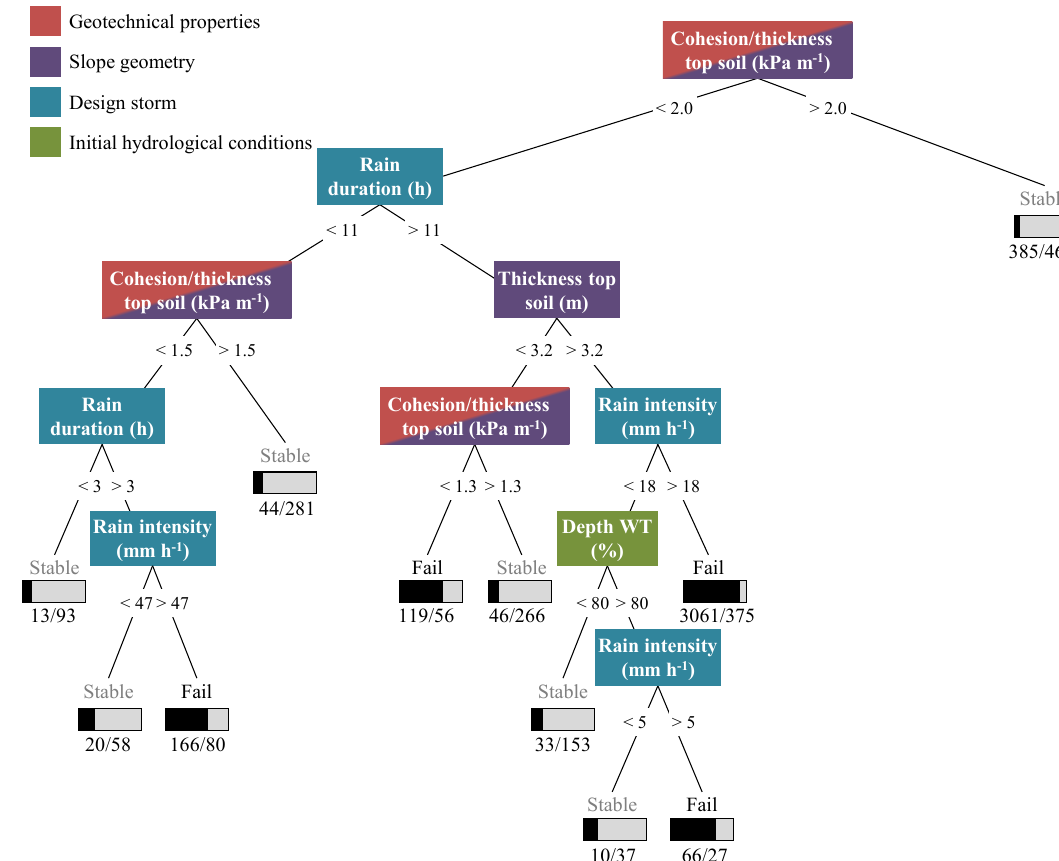
Figure 7. Classification tree of slope response, when adding an auxiliary variable (ratio between effective cohesion and thickness of topsoil) among uncertain input factors. The bar under each leaf shows the proportion and total number of simulations leading to slope failure (black bar, left hand number) or a stable slope (grey bar, right hand